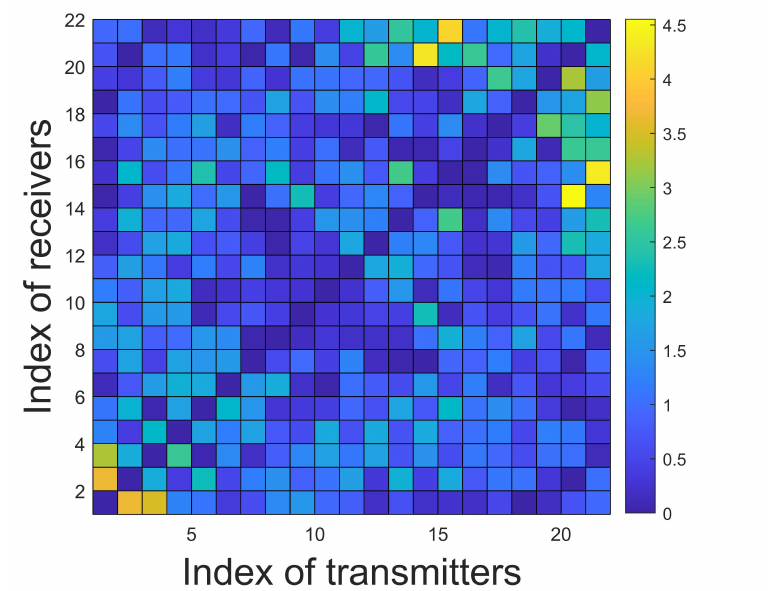
Figure 6. The absolute value of the traveltime data difference between SPR method with n nodes = 3 and k-Wave simulation. Colorbar: 0–4.5 µ